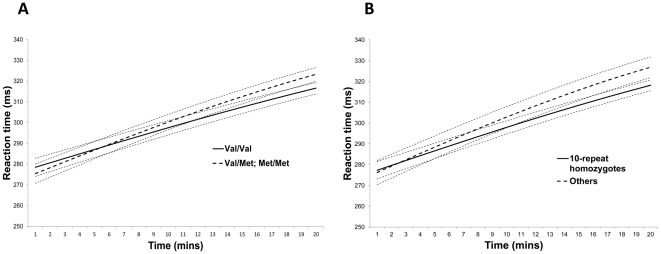
Average reaction time curves by allele group for DAT1 and COMT.Curves were plotted using predicted values calculated from average parameters A, T1 and T2 for each allele group. The thinner dotted curves represent the mean ± one standard error. Note that the curvature of the trends is only slight despite the use of an exponential equation; this is due to the bimodality of T1, for which large values cause the curve to approach linearity. Panel A: COMT allele groups. Panel B: DAT1 allele groups.